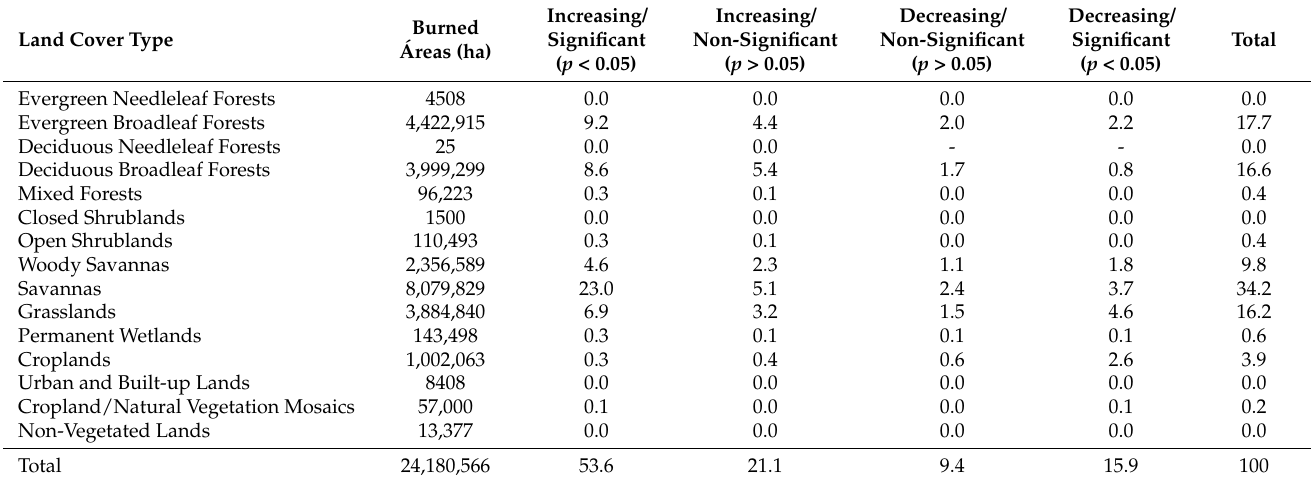
Table 2. Trends of natural regeneration in fire scar area for land cover types in Bolivia, based on the Mann-Kendall test (increasing, decreasing) and statistically significance values ( p < 0.05, p > 0.05). The data are presented in percentages in relation to the total burned area in the period 2001–2021.